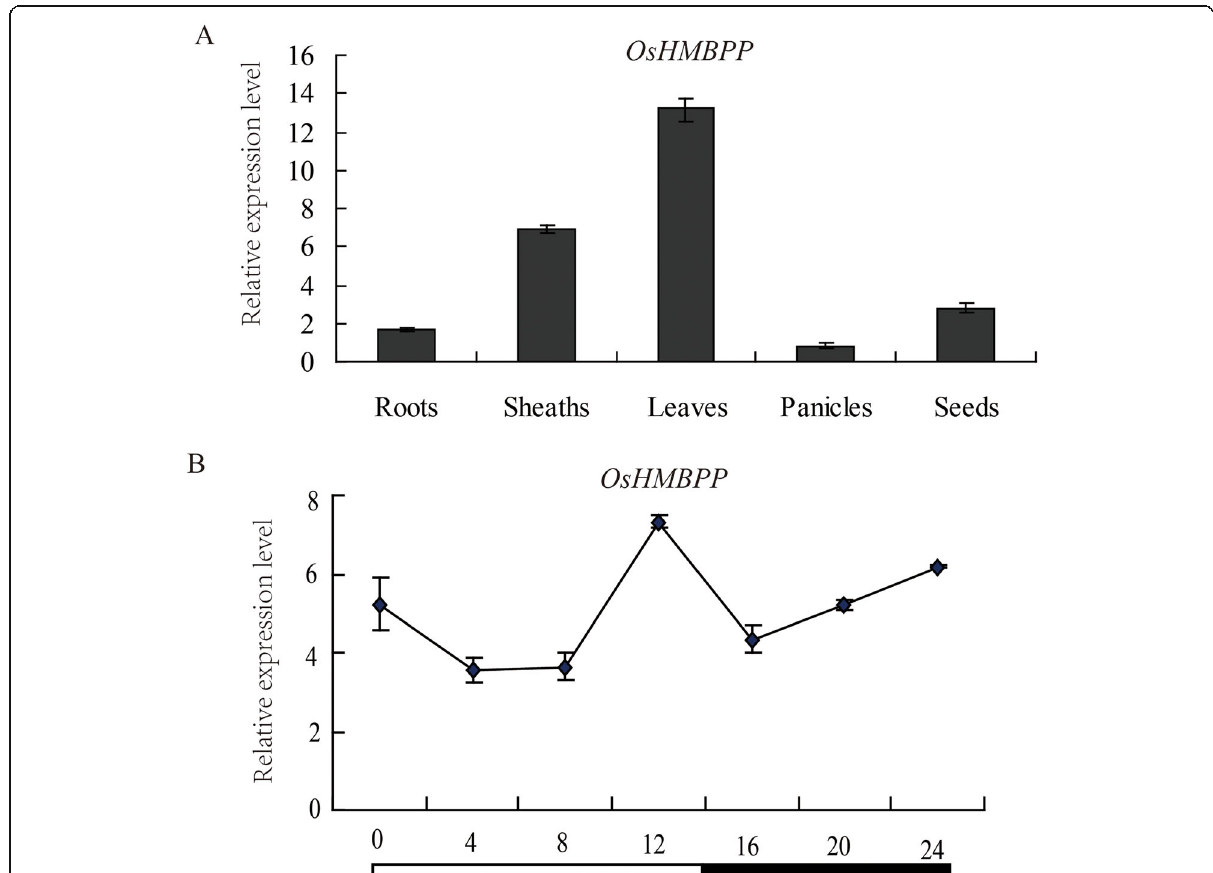
Fig. 3 Expression analysis of OsHMBPP . a Expression of OsHMBPP in roots, sheaths, leaves, panicles, and seeds of wild-type plants. b Expression pattern of OsHMBPP in a 14-h light/ 10-h dark cycle. Values represent the mean ± SD of three biological